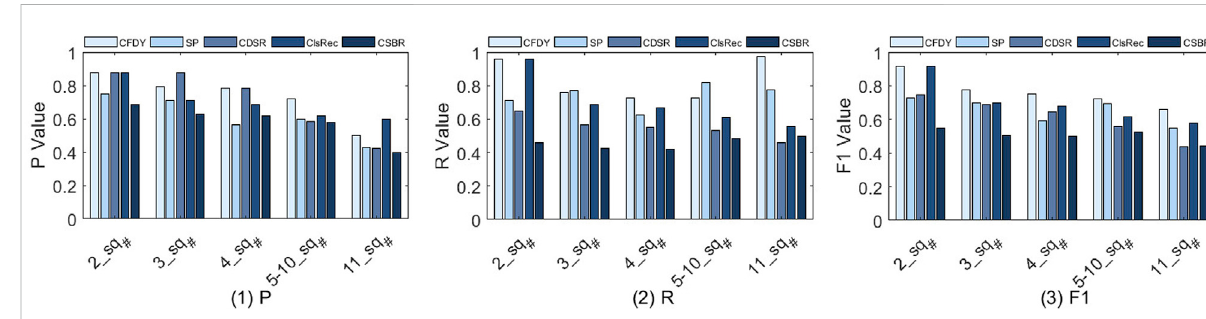
(cid:129) Figure 2(1) and Figure 2(2) show that, as sq